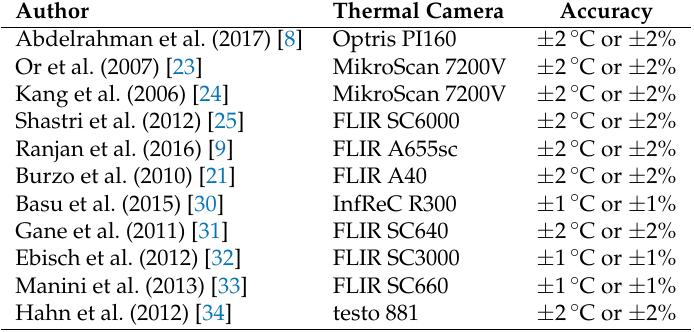
Table 1. Thermal cameras used in existing